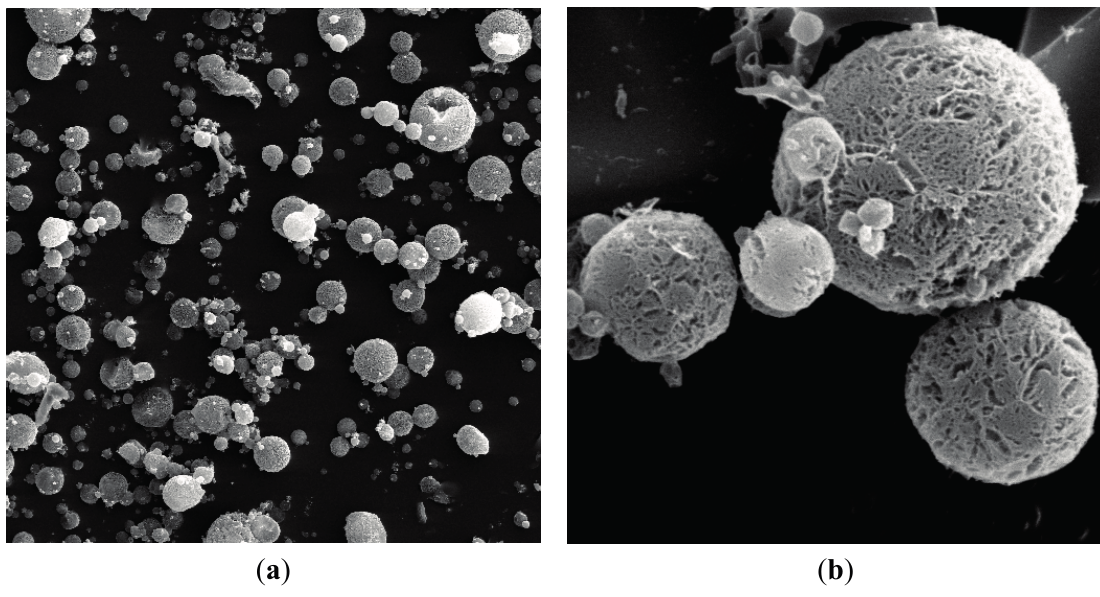
Figure 1. Scanning electron microscope photograph of budesonide (BUD) microspheres: ( a ) ×500; ( b )